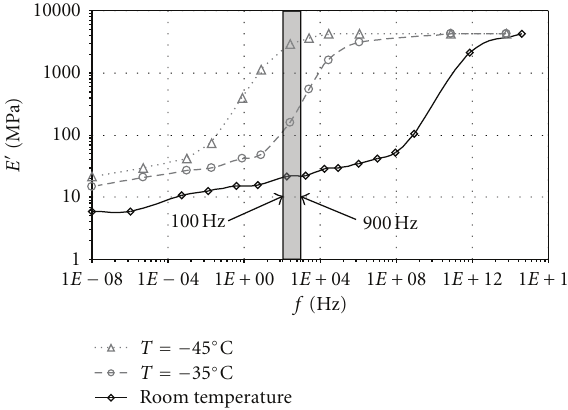
Figure 5: Storage modulus versus frequency curves of EPDM v1 in the case of 10-term generalized Maxwell model at room temperature and at temperatures of T = − 45 ◦ C and − 35 ◦ C (strain amplitude =